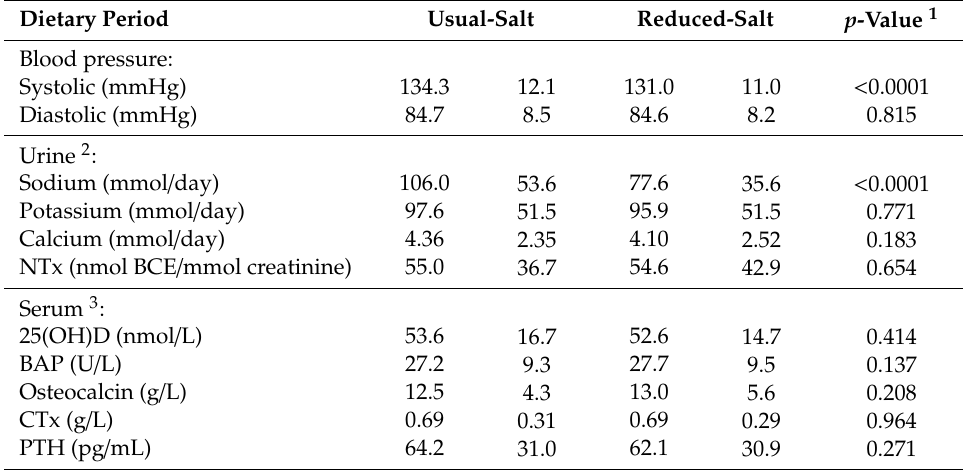
Table 2. Blood pressure, urinary, and serum biochemical variables in adults with mildly to moderately elevated blood pressure ( n 96) during the reduced-salt and usual-salt dietary periods.